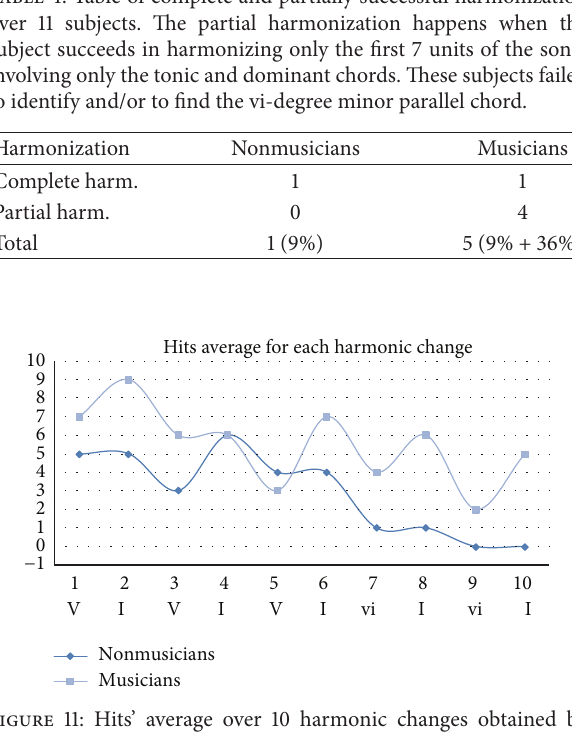
Figure 11: Hits’ average over 10 harmonic changes obtained by nonmusicians (blue line) and musicians (azure